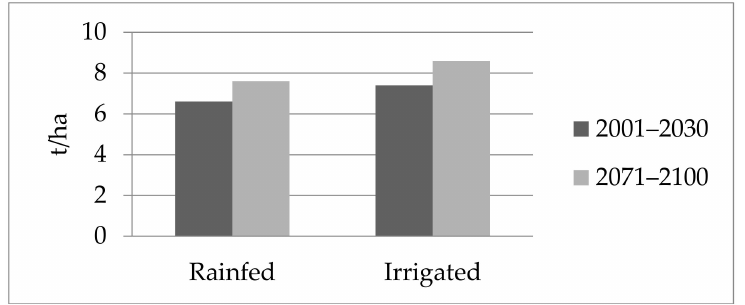
Figure 7. The difference in the predicted mean grain yield for the 2001–2030 and 2071–2100 periods under rain-fed and irrigated conditions.